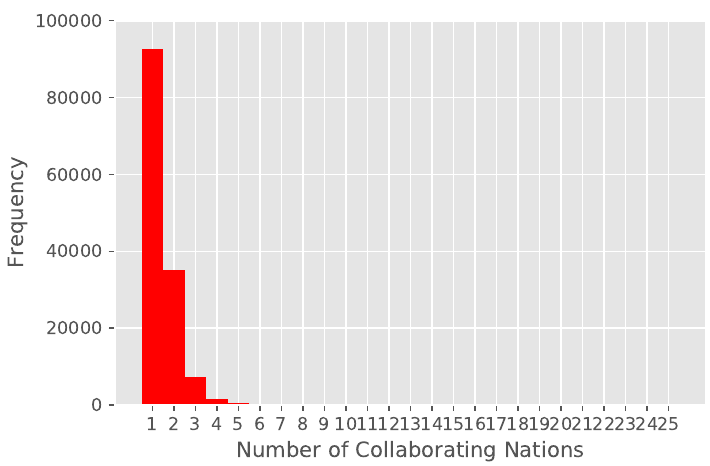
Figure 4. A histogram of the number of different nations represented on papers published in MDPI journals between 1996 and 2018 which include at least one author from a nation in the high-income classification.